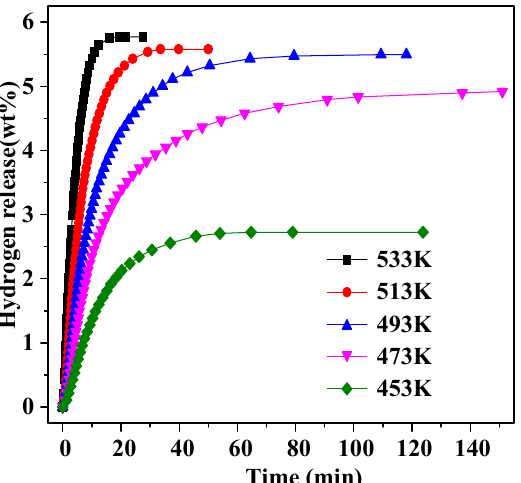
Figure 5. Hydrogen release of dodecahydro-N-ethylcarbazole over 3.0 wt% Pd/CNTs versus time at 453, 473, 493, 513 and 533 K.